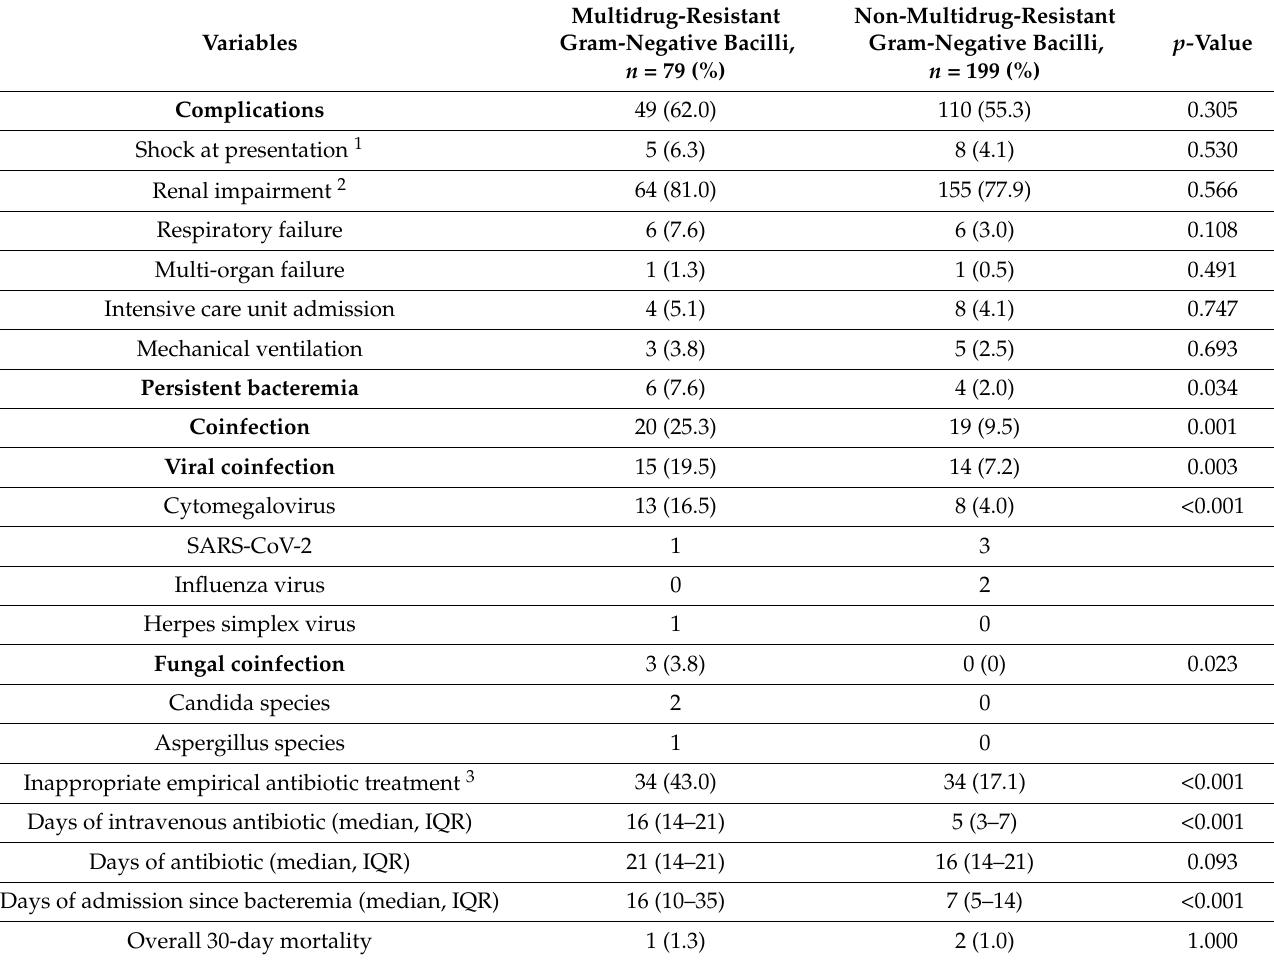
Table 5. Comparison of outcomes in 278 episodes of acute graft pyelonephritis with bacteremia in 214 KT recipients according to multidrug-resistant Gram-negative bacilli